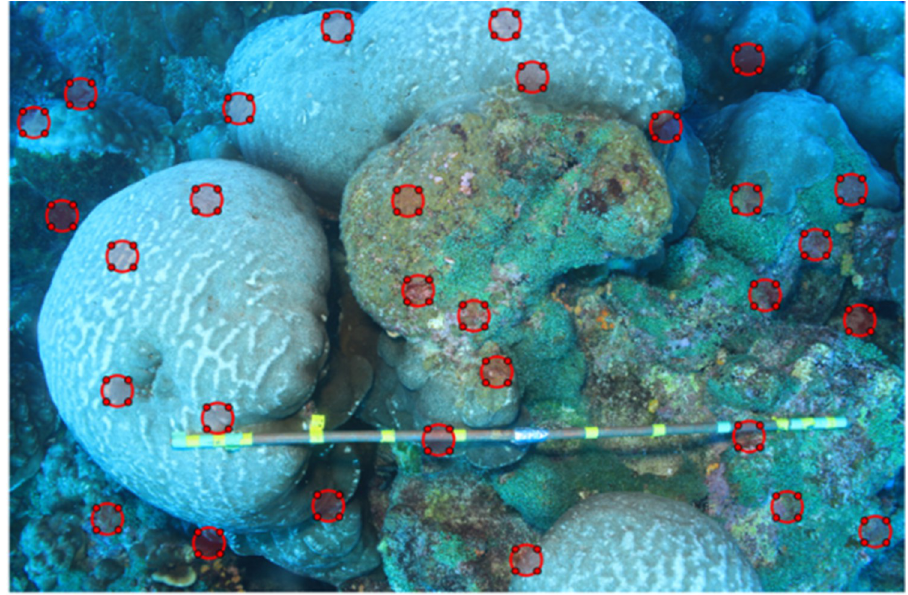
Fig 2. Coral with regions of interest (ROIs). Example of method used to determine percentage cover of C . chemnitzia , using circular regions of interest (ROIs), shown by the red circles on the image.